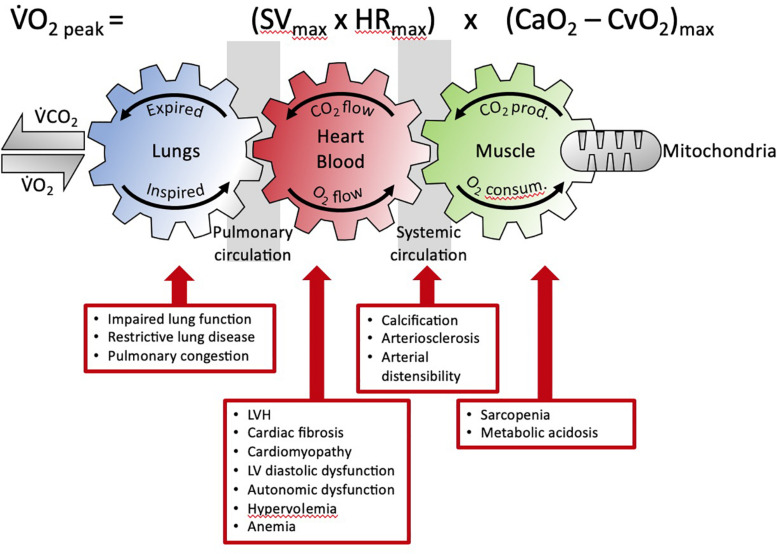
The Fick equation and the coupling of external and cellular respiration. The three interlinked gears represent the functional interdependence between the lungs, circulation and muscle. This facilitates O2 transport from the lungs to the mitochondria and, in reverse, CO2 from the muscle to the lungs (adapted from Wasserman, 1997). The detrimental multisystemic effects of kidney disease on this integrated physiological process are indicated. V̇O2, oxygen uptake; V̇CO2, carbon dioxide output; prod, production; consum, consumption; SV, stroke volume; HR, heart rate; CaO2, arterial O2 content; CaO2, venous O2 content; LVH, left ventricular hypertrophy.